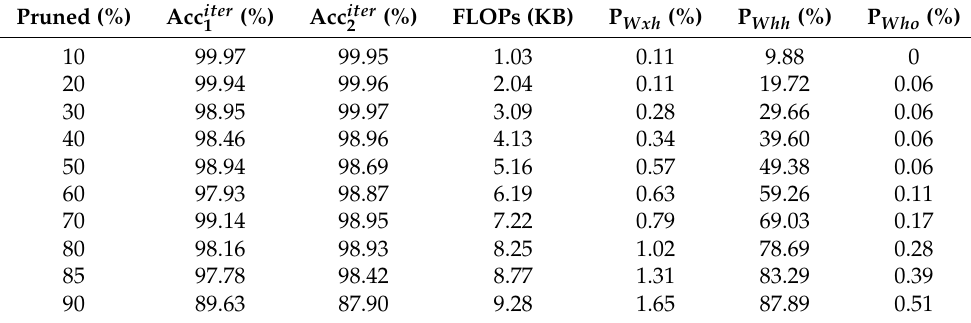
Table 6. Iterative layer-wise pruning performance of the model with 40 hidden neurons. Acc iter is the accuracy after removing the redundancy in W xh and W hh , and Acc iter important connections in W ho . P w (%) denotes the percentage of the removed weights over the entire network in different pruning rates.